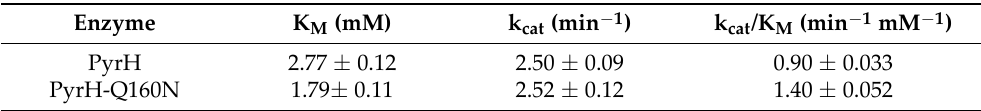
Figure 3. Chlorination of indicated peptides using PyrH. Values represent average ± SD ( n = 2). Table 2. Kinetic parameters for chlorination of GGW peptide using PyrH and PyrH‑Q160N enzymes. Values indicate average ± SD ( n =